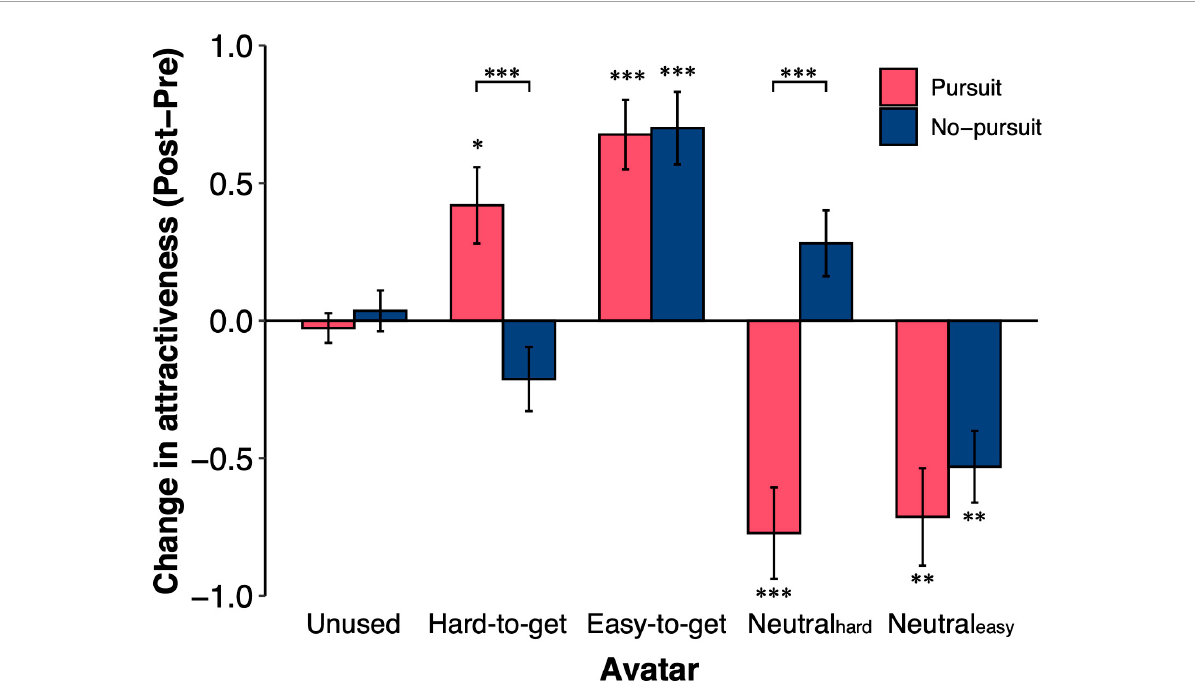
FIGURE3 Changes in attractiveness ratings after the avatar choice task. The figure shows the changes in the attractiveness ratings of the five types of avatars in the two groups. Changes in attractiveness ratings were calculated by subtracting the score at the pre-choice rating from that at the post-choice rating. The unused avatars were not used in the avatar choice task (i.e., 40 avatars). The other types of avatars (i.e., hard-to-get, easy-to-get, neutral hard , and neutral easy ) were used in the avatar choice task. The error bars represent the standard error of the mean. Asterisks denote whether the difference in attractiveness from before to after the avatar choice task was significant: ∗∗∗ p < 0.001, ∗∗ p < 0.01, and ∗ p <